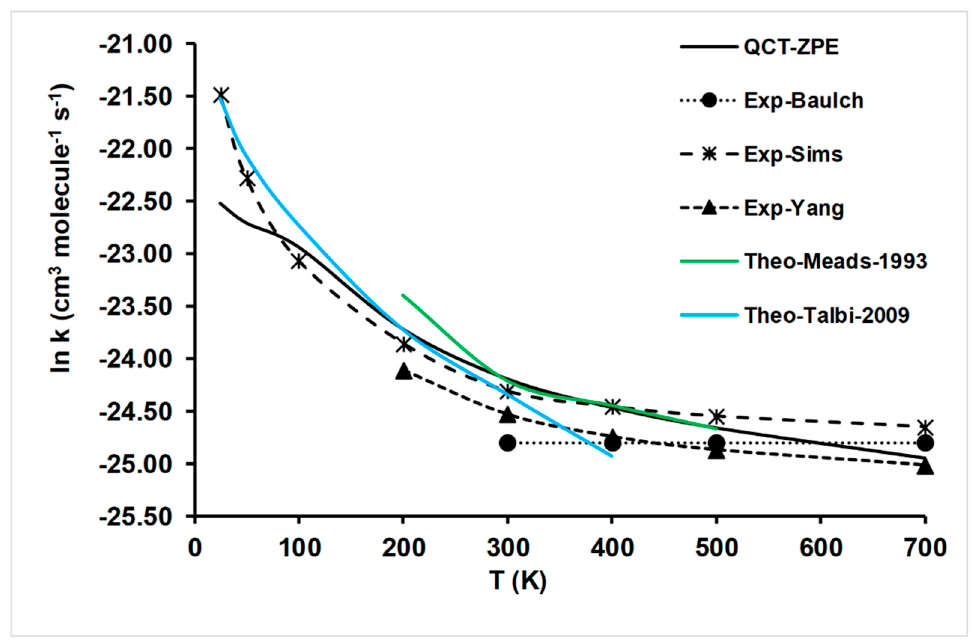
Figure 4. Rate constants (cm 3 molecule − 1 s − 1 ) for the title reaction. Present results (quasi-classical trajectory (QCT)-ZPE) on the basis of our PES-2020. Solid black line; experimental review from [9], black circles; experimental measurements from [10,11], black crosses; experimental measures from [1], black triangles; theoretical results from [6]; solid green line; theoretical results from [7], solid blue line. Table 3. Rate constants (cm 3 molecule − 1 s − 1 ) for the CN + NH 3 reaction.